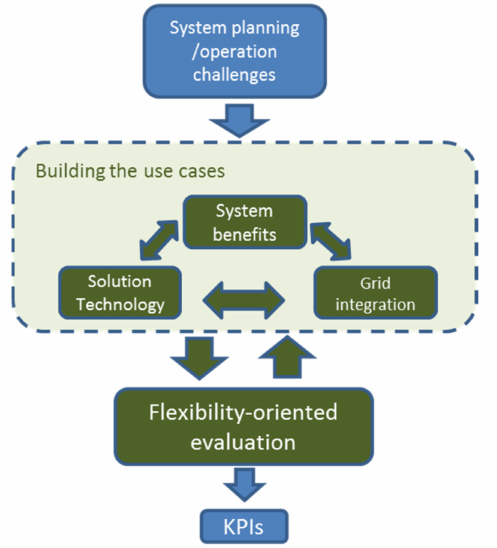
Figure 2. Flowchart for strategic decision-making through innovation